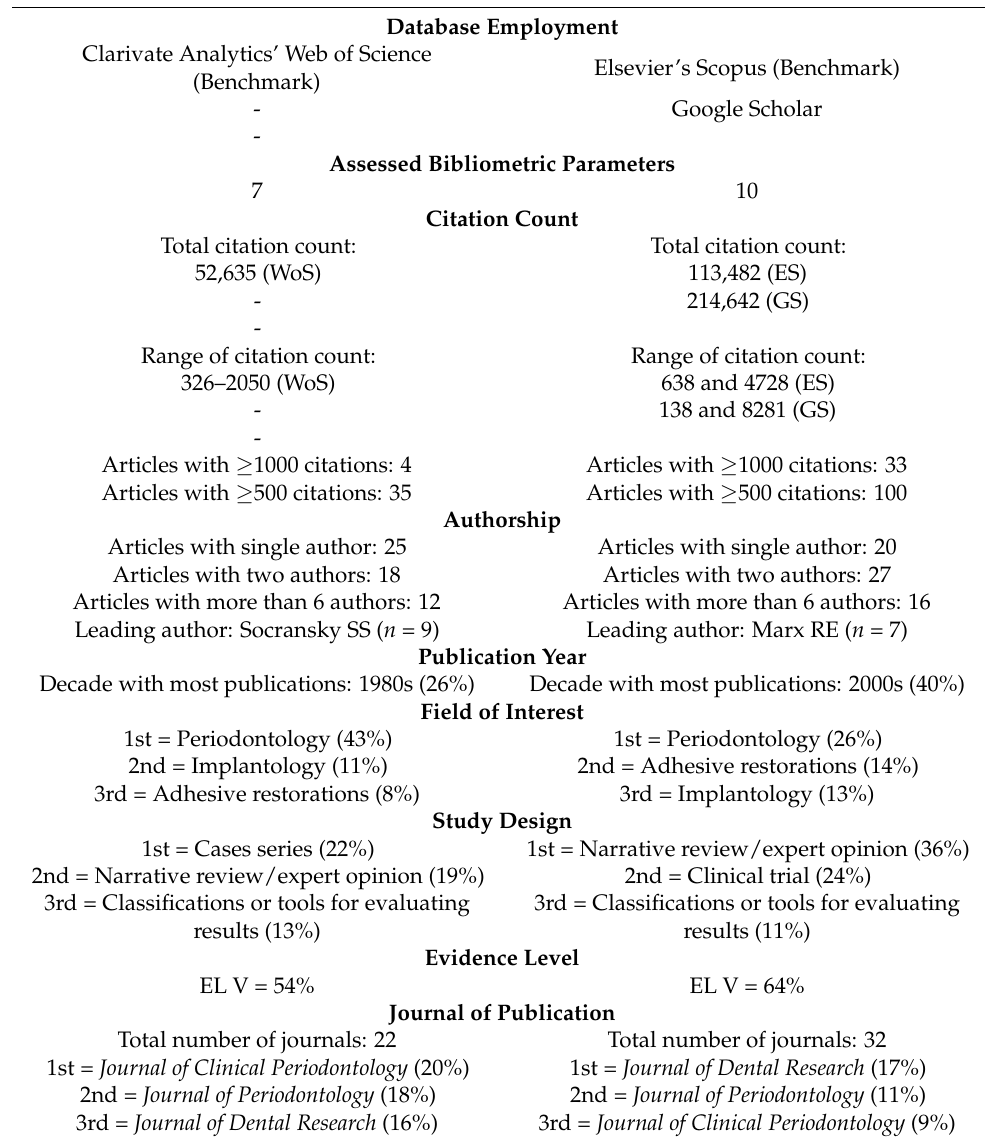
Table 4. Comparative analysis of the differences between the present study and Feijoo et al.